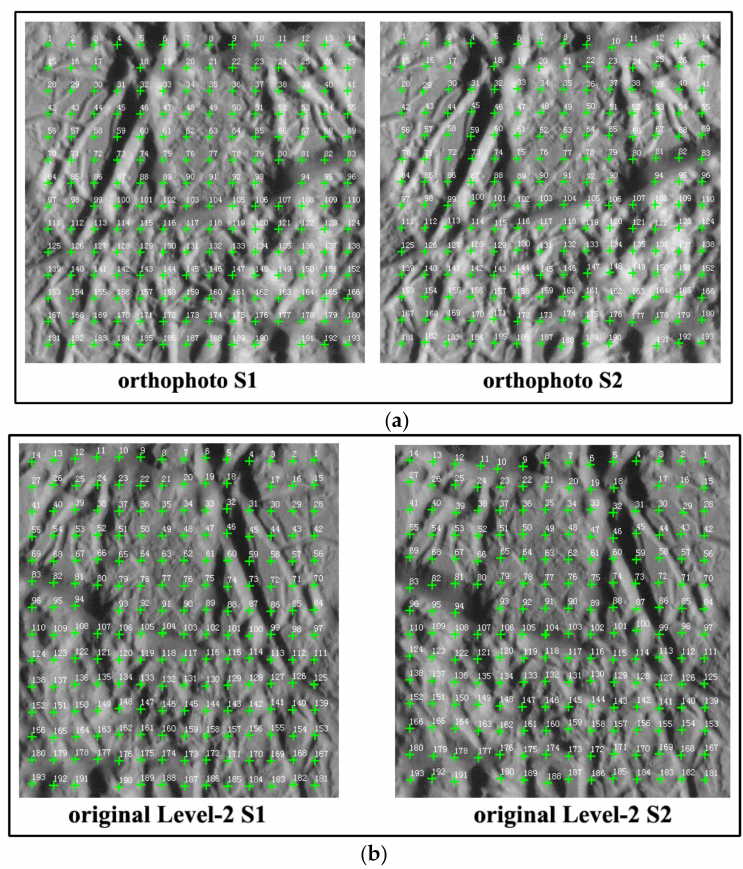
Figure 13. The thinned conjugate points for orbit 5124 at the original image resolution level. ( a ) conjugate points on orthophotos; and ( b ) conjugate points on the original HRSC Level-2 images. Green crosses mean matched conjugate points. Numbers are used to show the relationship between the matched points on orthophotos and the matched points on the original HRSC Level-2